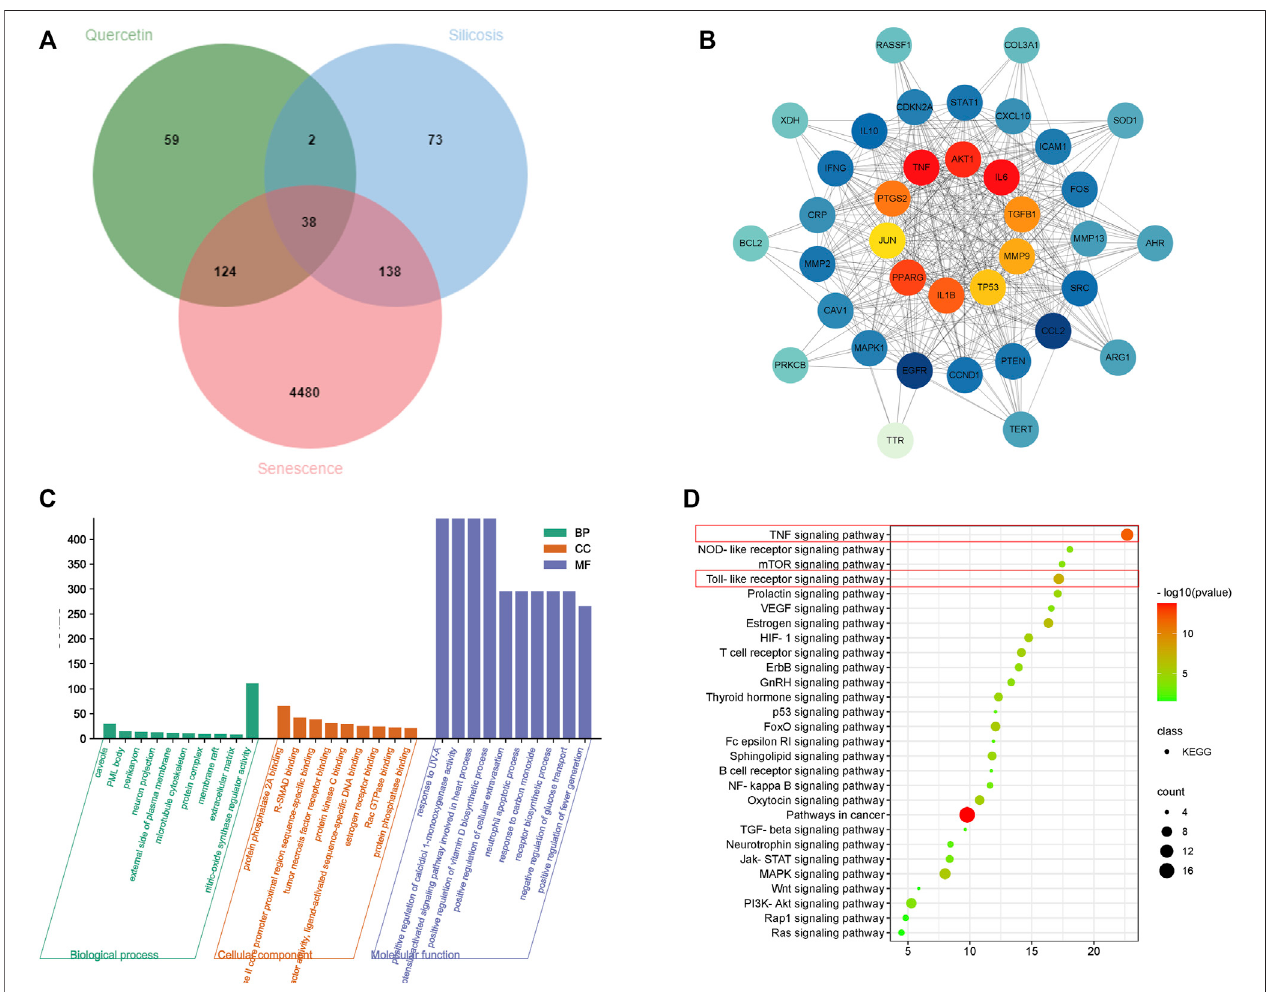
FIGURE 6 | Network pharmacology analysis of a quercetin-senescence-silicosis intersection target network. (A) Venn diagram showing a quercetin-senescence- silicosisintersectiontargetnetwork. (B) PPInetworkofquercetin-senescence-silicosisintersectiontargets. (C) GOenrichmentanalyses. (D) KEGGenrichmentanalyses showing the top 10